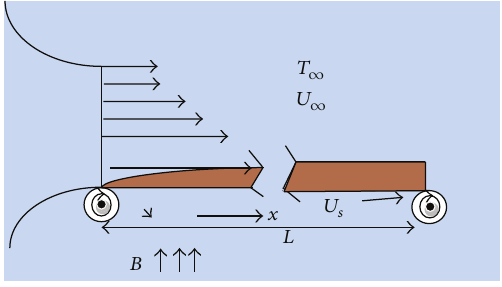
Figure 1: Flow configuration and coordinate